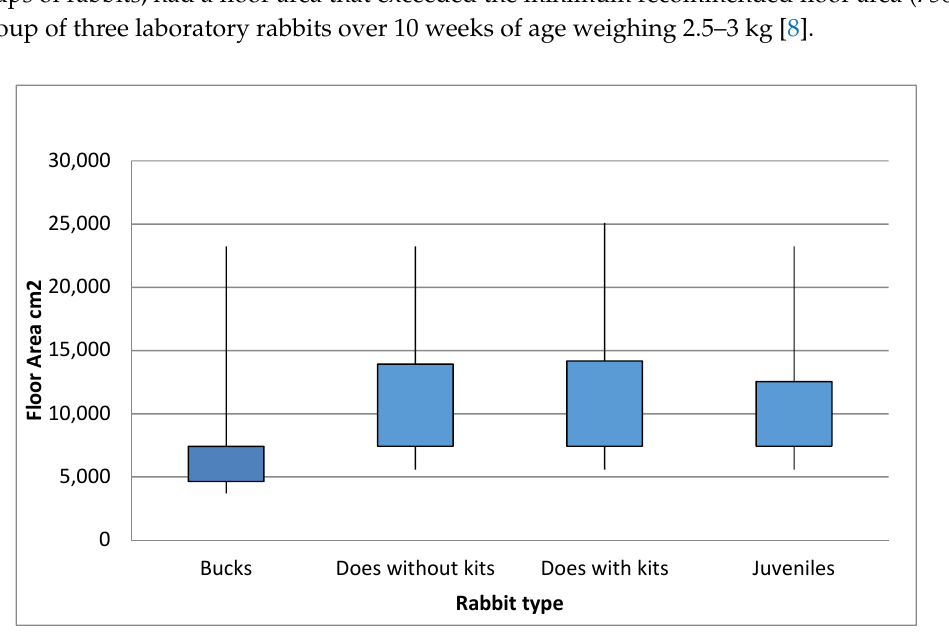
Figure 1. Boxplots showing the range, and interquartile range, of housing sizes provided for singly housed rabbits.